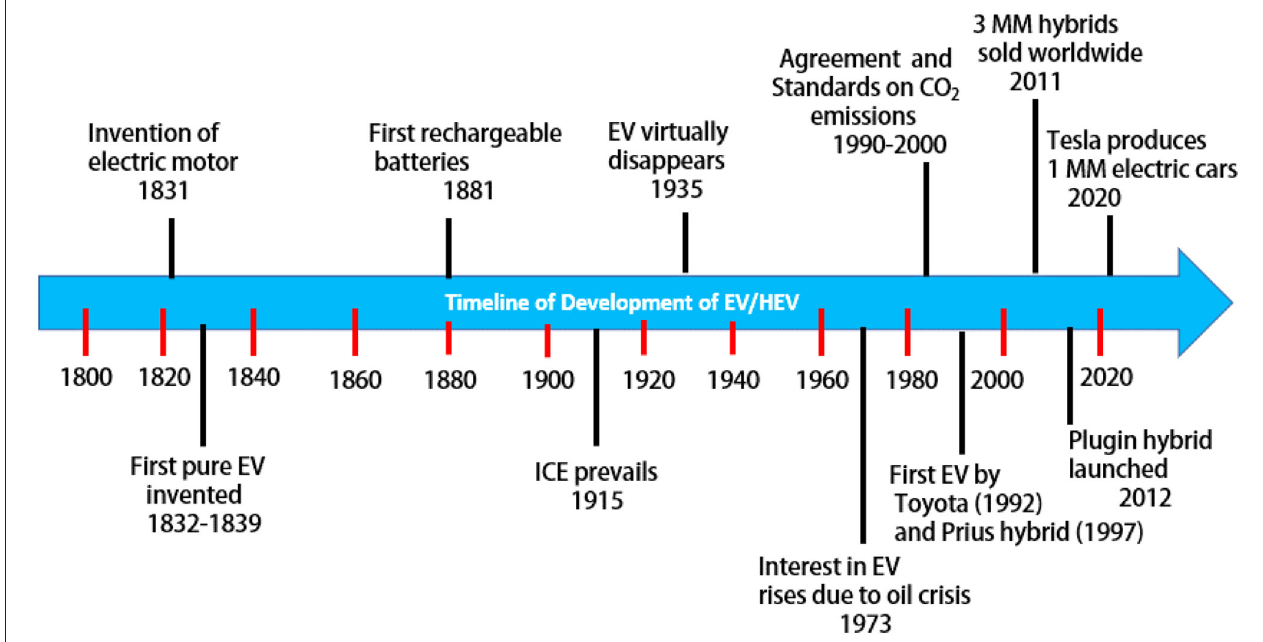
FIGURE 1 | Historical timeline of the development of EV/HEV.